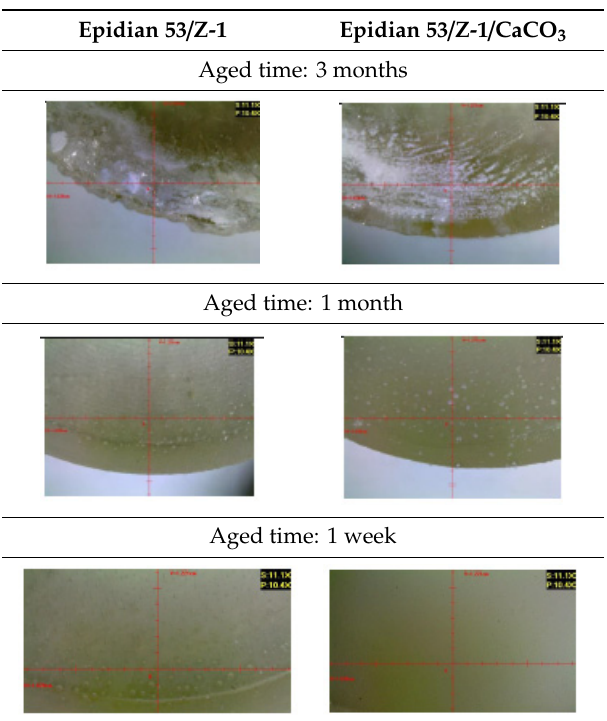
Table 8. Samples aged in 1/2 reference salinity environment.